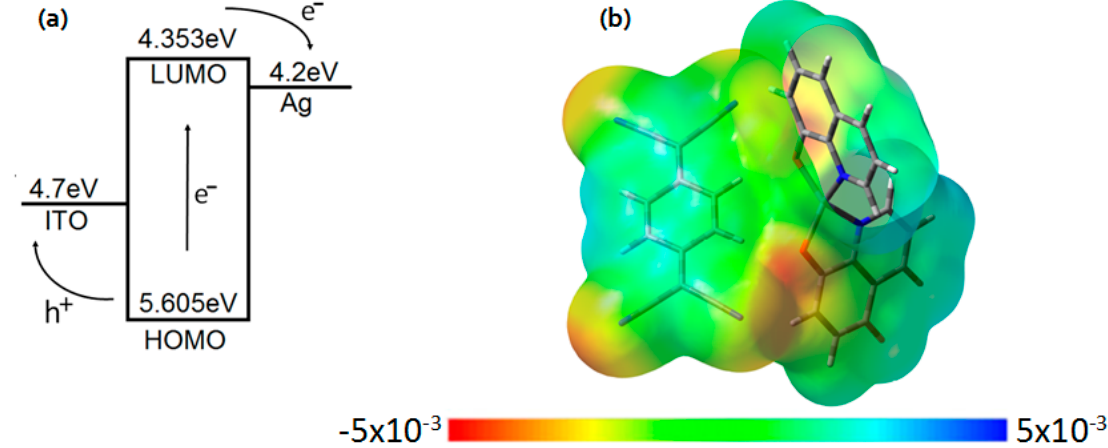
Figure 3. ( a ) Schematic energy level diagram of the device and ( b ) electrostatic potential mapped on the electron density for ZnQ 2 -TCNQ from B3PW91/6-31G** calculations.